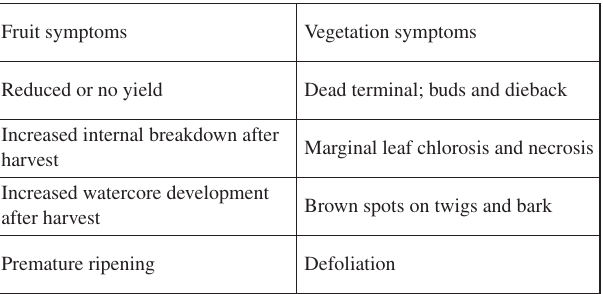
Table 3: The most common boron toxicity symptoms Fruit symptoms Vegetation symptoms Reduced or no yield Dead terminal; buds and